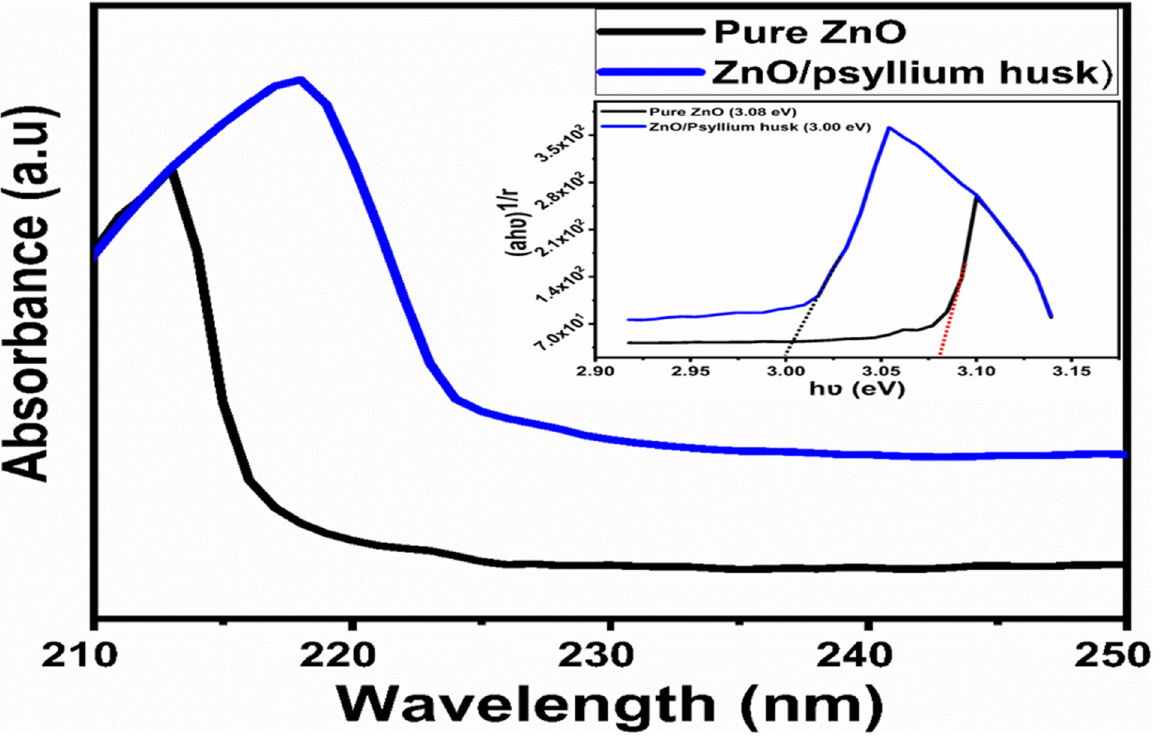
Figure 4. Absorption spectra inset with Tauc plots for pure ZnO and its hybrid with psyllium husk.